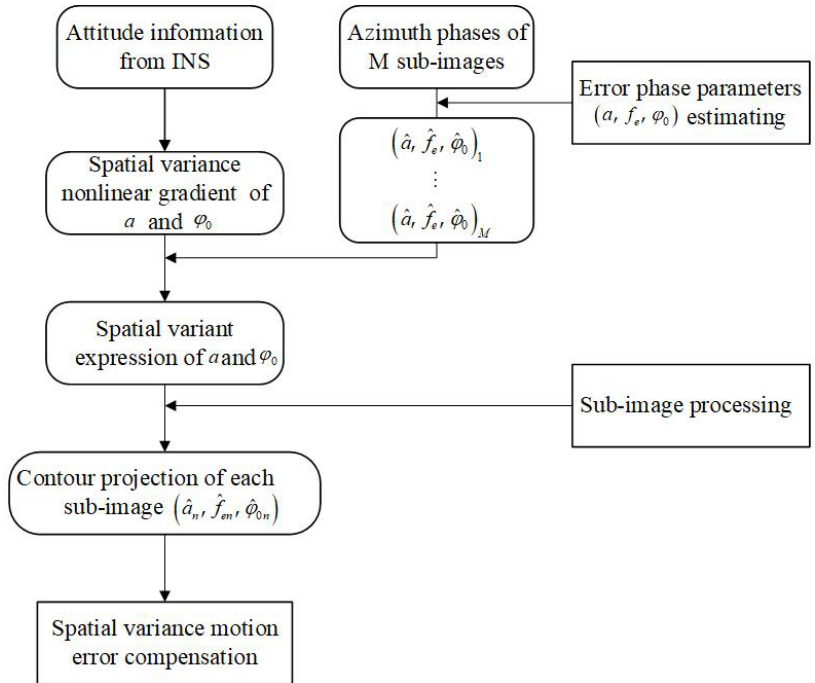
Figure 4. The flowchart of the proposed spatial variant high-monofrequency MOCO